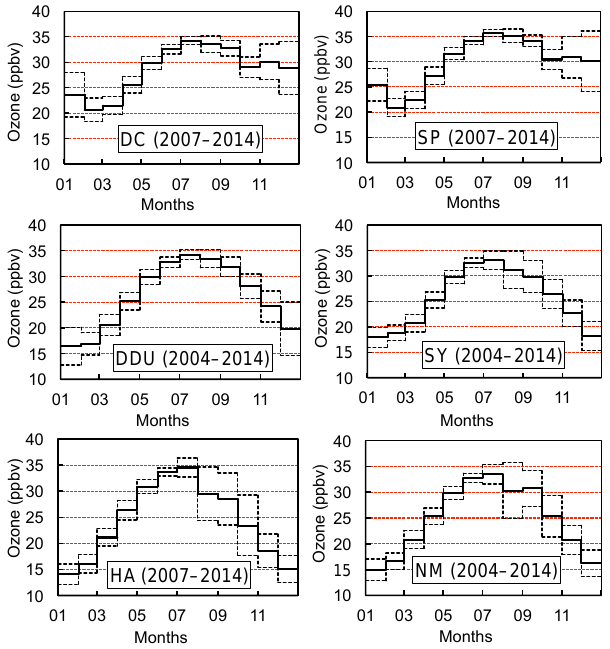
Figure 13. Monthly averaged ratios and standard deviations of ozone mixing ratios at Concordia (denoted DC), the South Pole (SP), Dumont d’Urville (DDU), Syowa (SY), Halley (HA), and Neumayer (NM). The standard deviations represent day-to-day